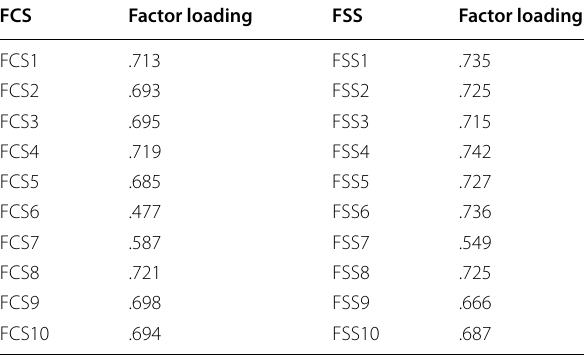
Table 4 Factor loadings for FCS and FSS scales